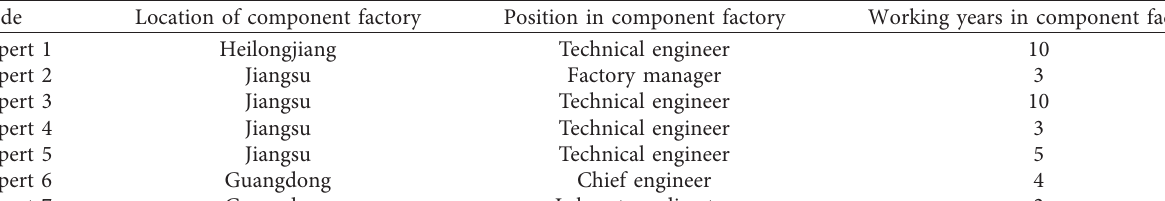
Table 1: Basic information of component factory experts.